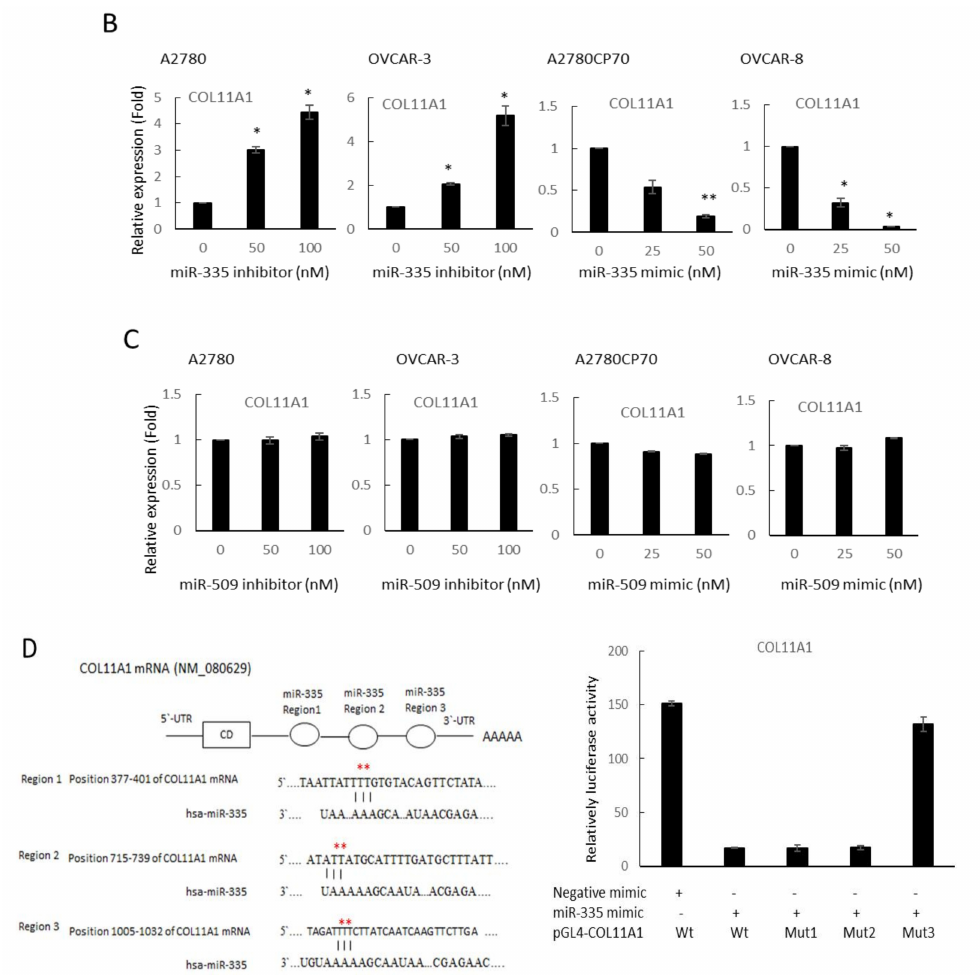
Figure 1. miR-335/miR-509 expression in epithelial ovarian carcinoma cells and their correlation with collagen type XI alpha 1 expression. ( A ) Messenger RNA (mRNA) expression levels of collagen type XI alpha 1 (COL11A1), miR-335, and miR-509-3p, in a panel of five ovarian cancer cell lines, were evaluated by real-time reverse transcription-polymerase chain reaction (RT-PCR). All experiments were performed in triplicate. ( B ) mRNA expression levels of COL11A1 in A2780 and OVCAR-3 cells transfected with miR-335 inhibitor and A2780CP70, as well as OVCAR-8 cells transfected with miR-335 mimic, are evaluated by real-time RT-PCR. All experiments are performed in triplicate; * p < 0.05, ** p < 0.01, compared with control. ( C ) mRNA expression levels of COL11A1 in A2780 and OVCAR-3 cells transfected with miR-509-3p inhibitor, as well as A2780CP70 and OVCAR-8 cells transfected with miR-509-3p mimic, were evaluated by real-time RT-PCR. All experiments are performed in triplicate. ( D ) Left panel: the putative miR-335 binding site in its 3 (cid:48) UTR (region 1, 2, and 3) contains mutant wt-COL11A1 and corresponding mut-COL11A1 (red star). Right panel: wt-COL11A1/mut-COL11A1 vector and miR-335 NC/miR-335 mimic were co-transfected into A2780CP70 cells. Compared with the control group, miR-335 mimic transfection significantly reduced the luciferase activity of the wt-COL11A1 reporter gene. In co-transfected cells with miR-335 and mut-COL11A1 (region 3) reporter genes, there was no significant decrease in reporter gene